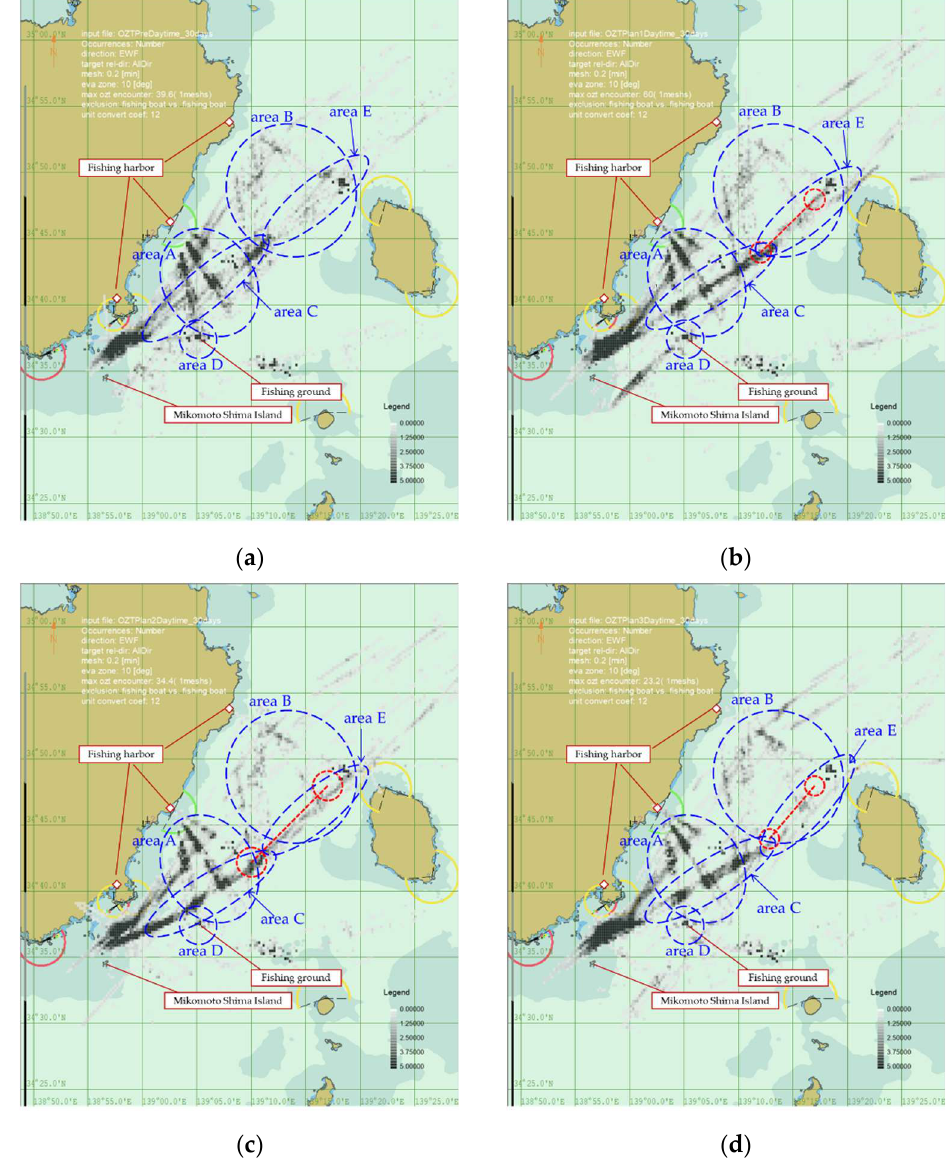
Figure 13. Distribution map of dangerous OZT occurrences between two merchant ships or a mer- chant ship and a fishing boat for 24 h during daytime per day: ( a ) present traffic, ( b ) Plan 1, ( c ) Plan 2, and ( d ) Plan 3. (Sources: simulation results data of [8]).